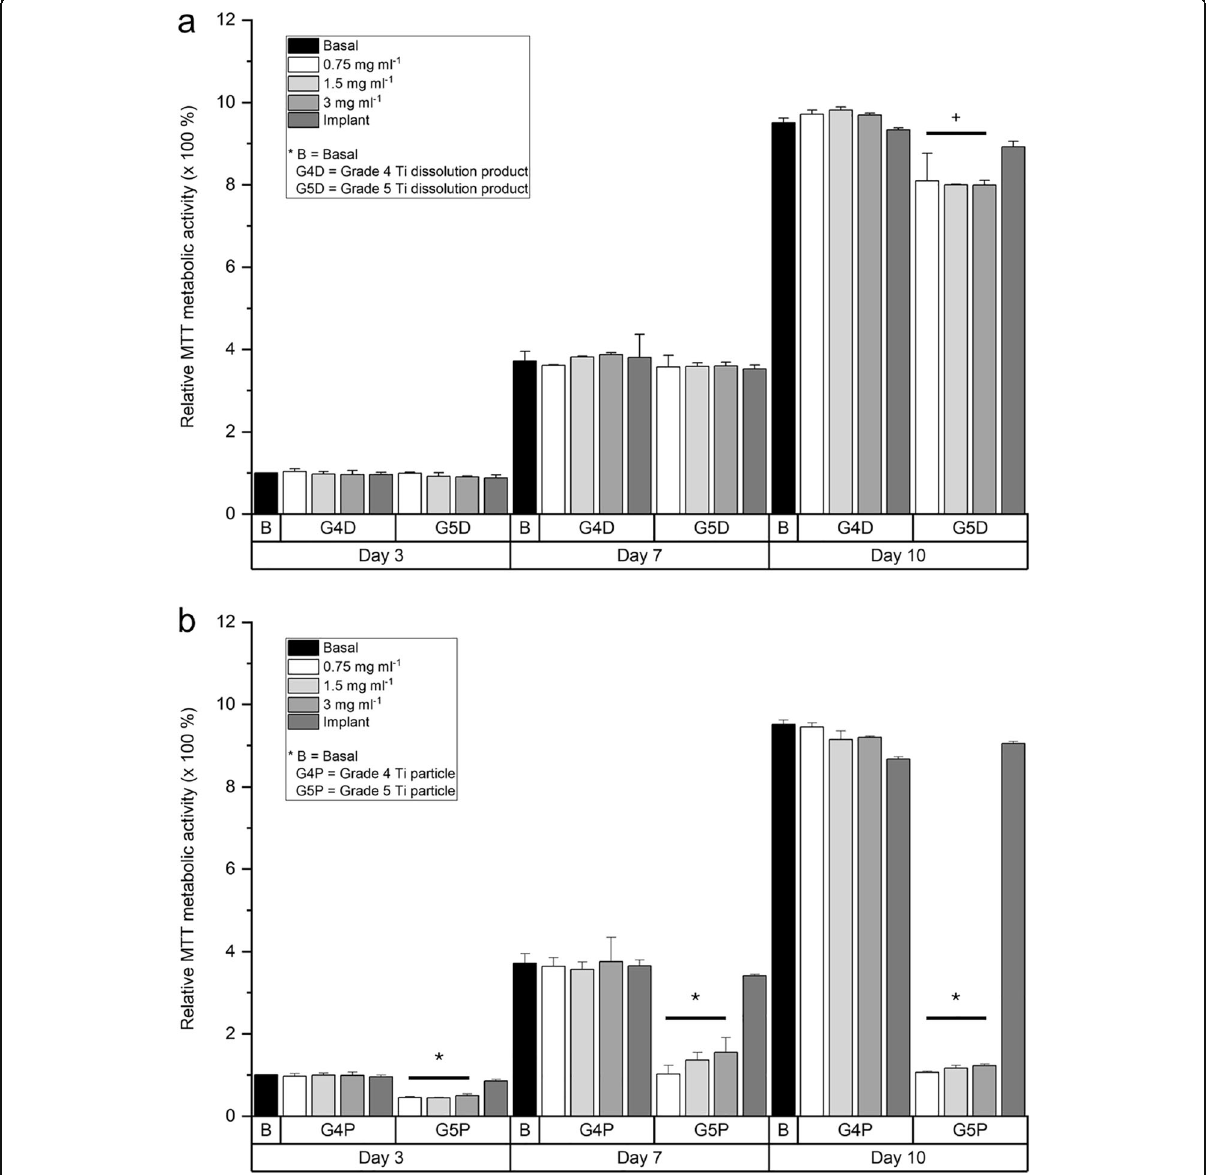
Fig. 5 The effect of grade 4 and grade 5 implant particles on human gingival fibroblast viability in vitro. Viability was determined using an MTT metabolic activity assay. Cells were exposed to either a dissolution products (ions and nanoparticles) or b culture medium containing suspended implant particles throughout the duration of the culture period. Cells were exposed to various concentrations of particles (0.75, 1.5 or 3 mg ml − 1 ). Basal medium and basal medium containing unprocessed dental implants were used as controls. All results were normalized against the value of basal medium at day 3. Results presented as mean ± standard deviation, n = 3. The asterisk indicates p < 0.05, and + indicates 0.05 < p < 0.1 when compared to basal medium control at each time